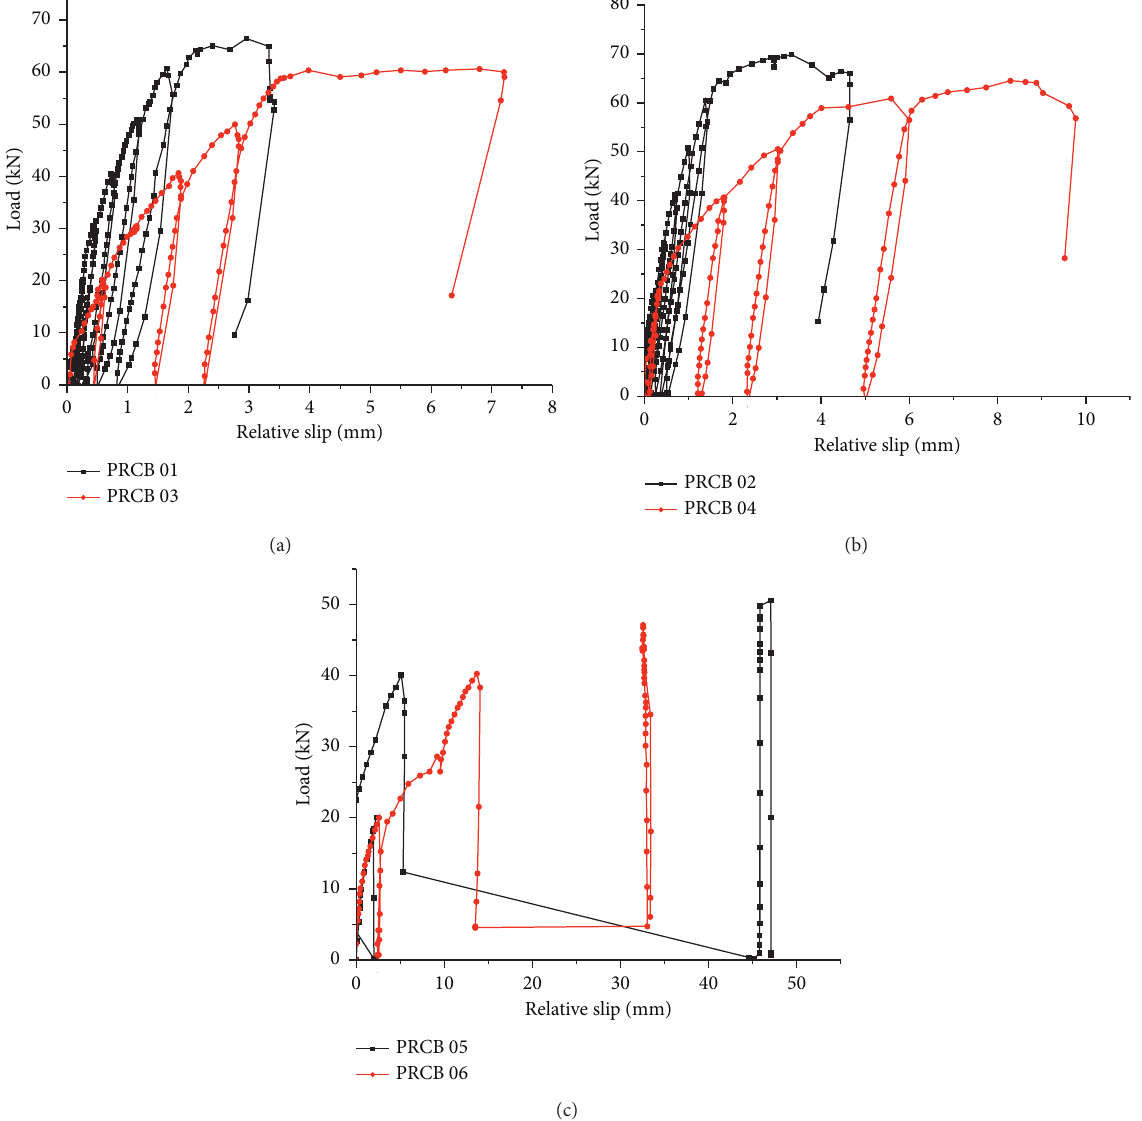
Figure 11: Load relative slip